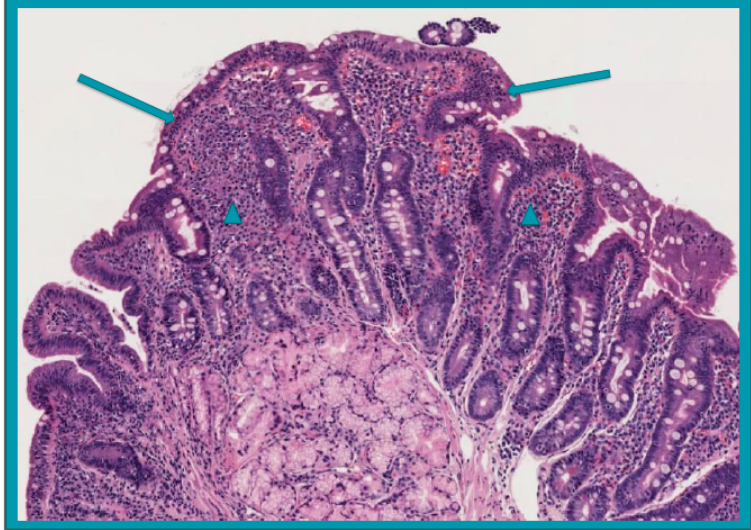
Figure 1. Histological features of duodenal mucosa of active coeliac disease showing subtotal villous atrophy with crypt hyperplasia and heavy lymphocytic inflammatory infiltrate in both the epithelial (arrows) and lamina propria (head arrows) compartments (hematoxylin-eosin, original magnification × 100).